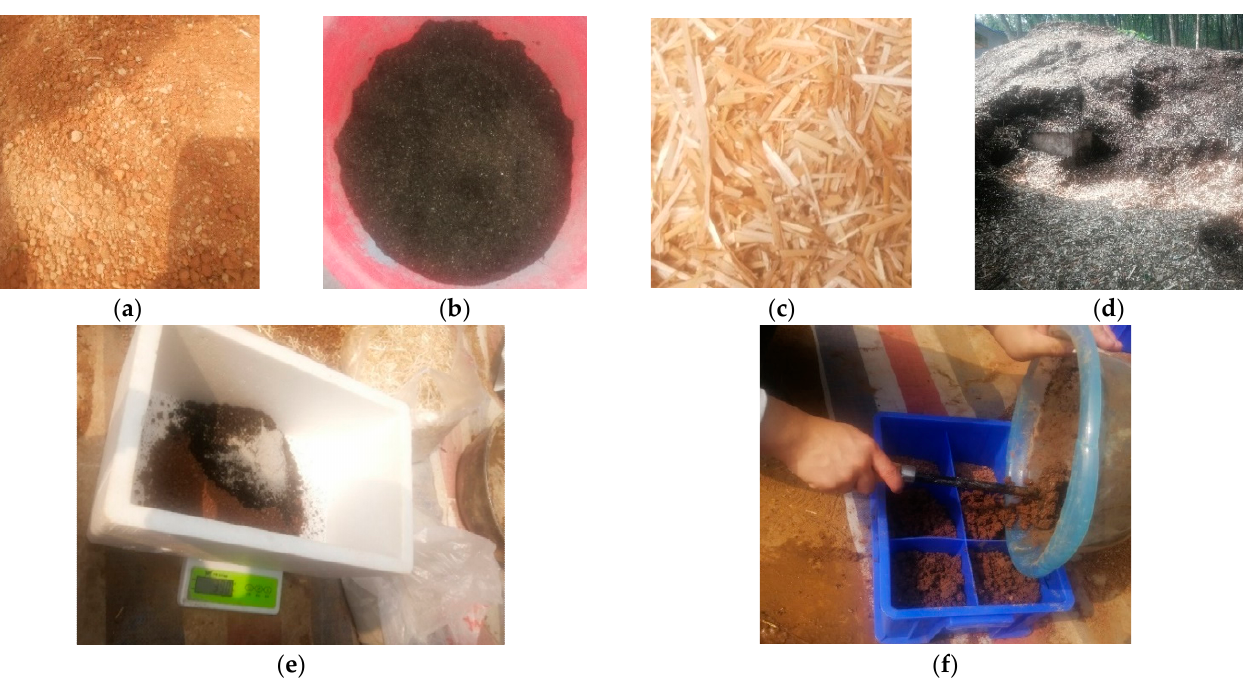
Figure 2. MSW used for VC sample production. ( a ) Soil; ( b ) KW fertilizer; ( c ) wheat straw; ( d ) fallen leaves; ( e ) mixing; ( f ) filling the mold.